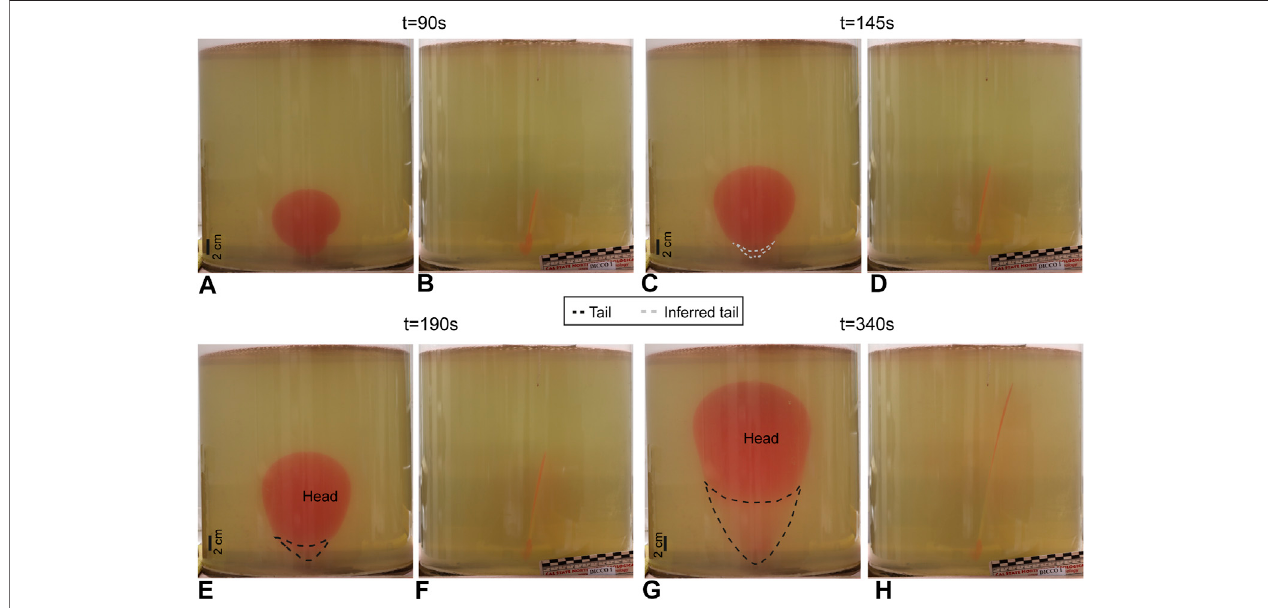
FIGURE 2 | Experiment Dike 1. Front (Panels A,C,E,G ) and lateral (Panels B,D,F,H ) view of the dike during the fi rst (Panels A,B ) and second phase ( C – H ).